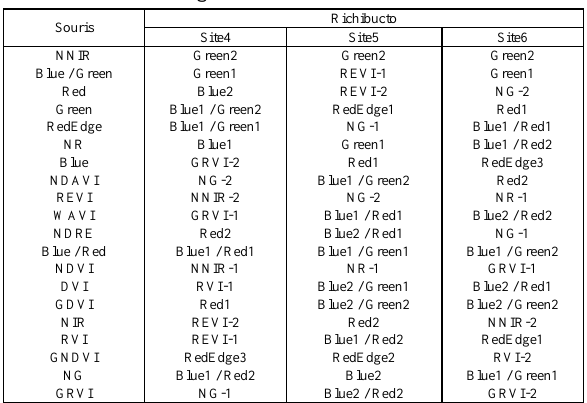
Table 11. List of the 20 most important input variables computed when applying RF to the original band reflectance, associated vegetation indices, and bathymetric ratios of the UAV images as a function of the image or site.